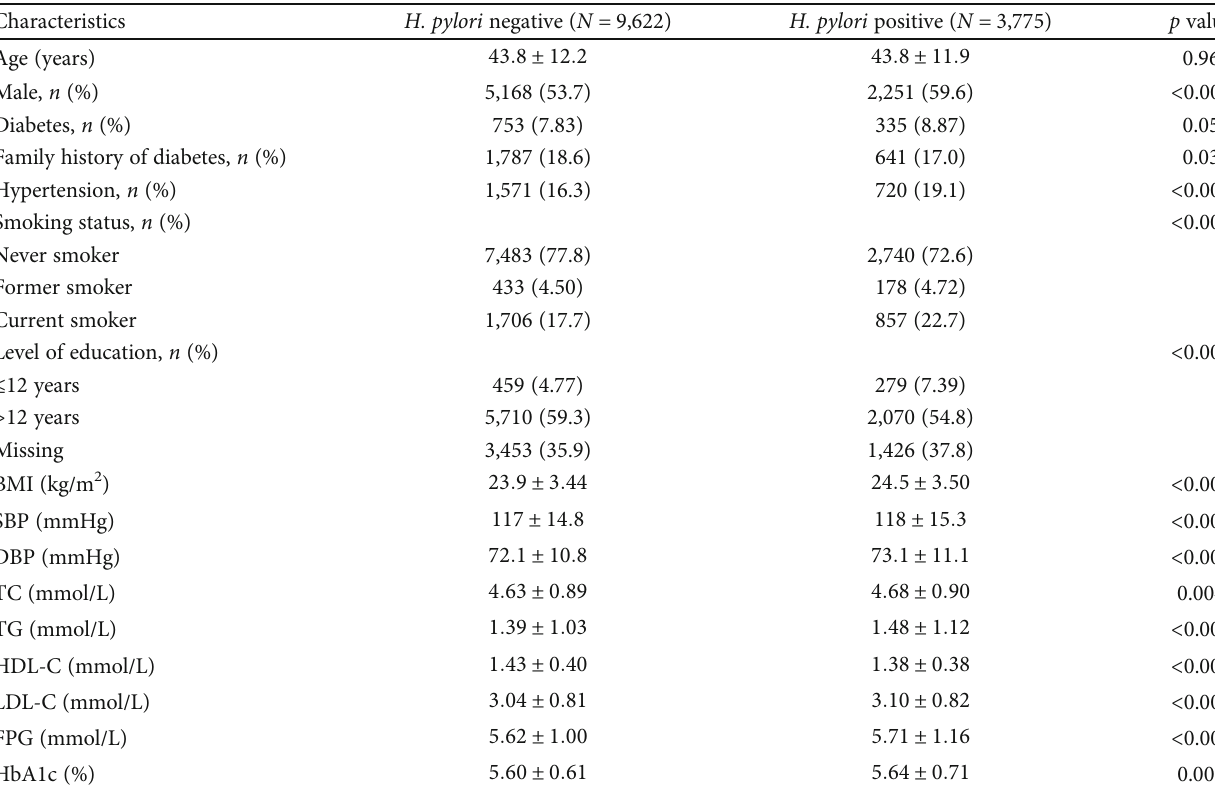
Table 1: Characteristics of participants according to the status of H. pylori infection † .